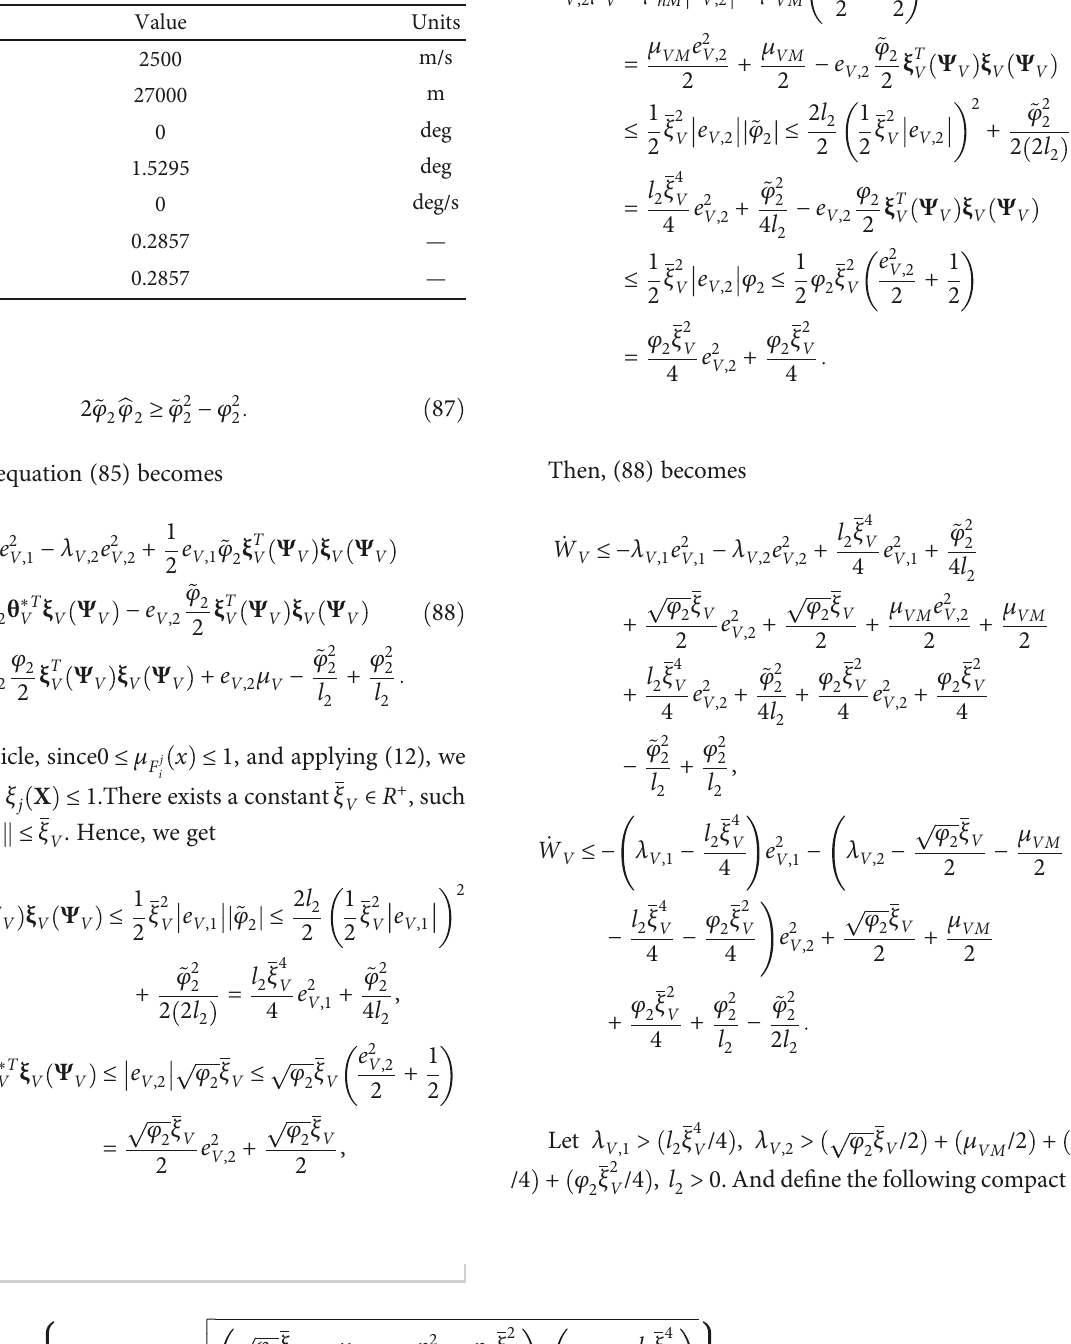
Table 1: Initial trim